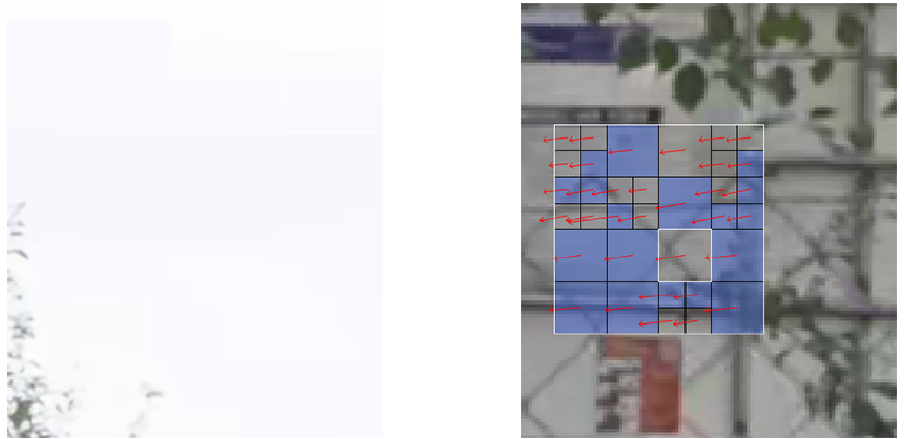
Figure 4. Example of low spatial complexity ( left ) and high spatial complexity ( right ) images.